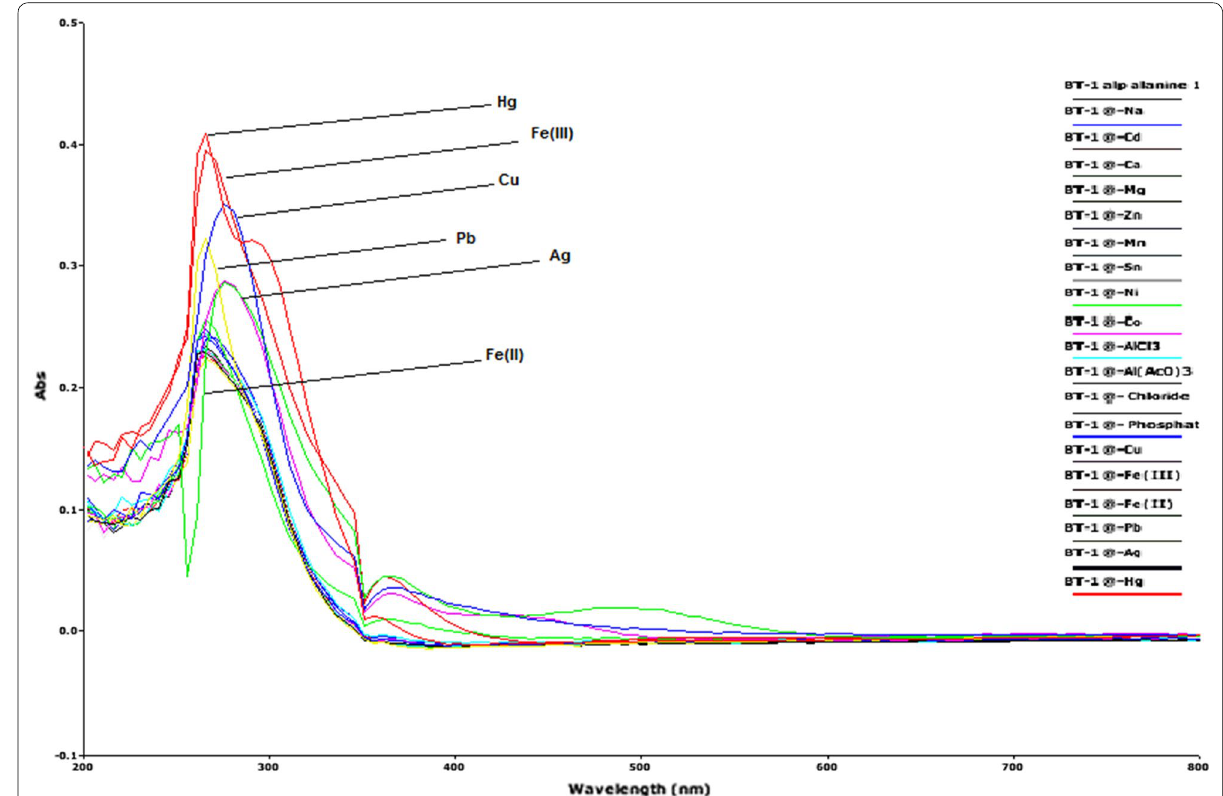
Fig. 4 Interactions of isomer 1A with various metal ions and tetrabutylammonium